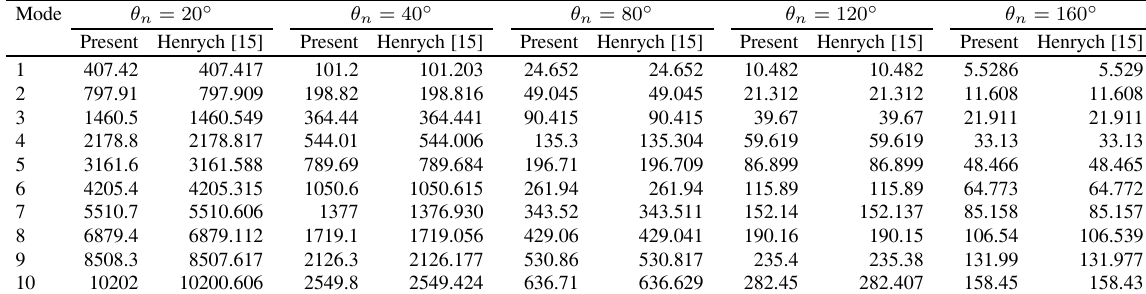
Table 8 Dimensionless natural frequencies of a clamped-hinged uniform arch